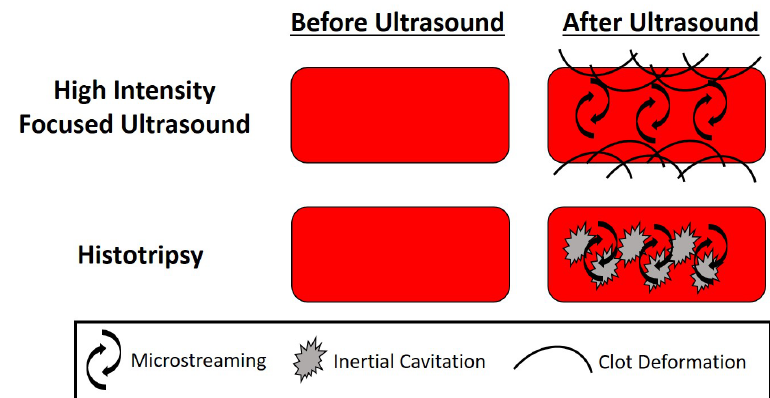
Figure 3. Schematic of Therapeutic Ultrasound for